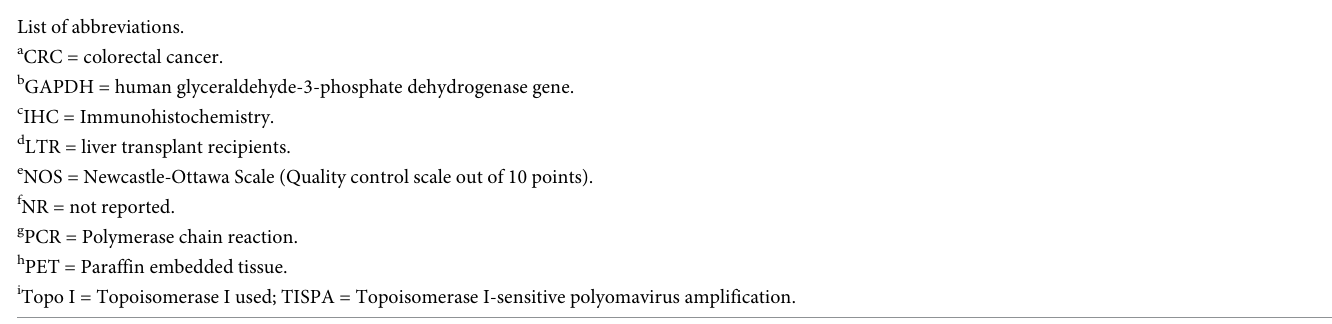
Table 2. JCV T-antigen protein expression by IHC, Odds ratios in cases vs. controls.